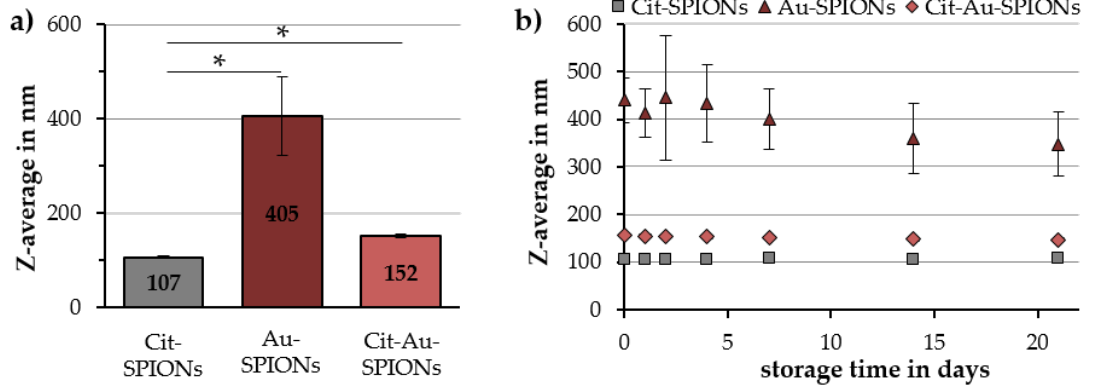
Figure 1. ( a ) Particle dispersions of pure citrate-stabilized (Cit)-superparamagnetic iron oxide nanoparticles (SPIONs) (left), Au-SPIONs (middle) and Cit-Au-SPIONs (right) as well as scanning electron microscopy (SEM) images of ( b ) pure Cit-SPION clusters, ( c ) Au-SPION clusters and ( d ) Cit-Au-SPION clusters.